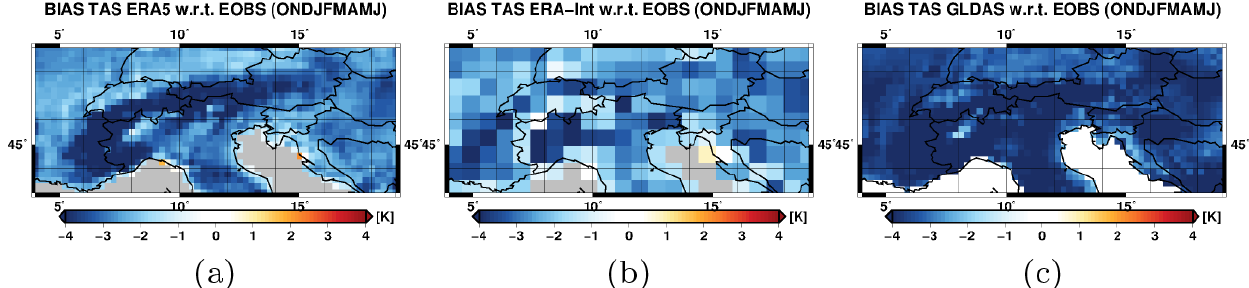
Figure D1. BIAS of ERA5, ERA-Interim, and GLDAS air temperatures with respect to EOBS observations over the greater Alpine region. Temperatures have been averaged over the months from October to June and over the period 1980–2014 in the case of ERA5 and ERA- Interim, and over the period 2000–2014 in the case of GLDAS.